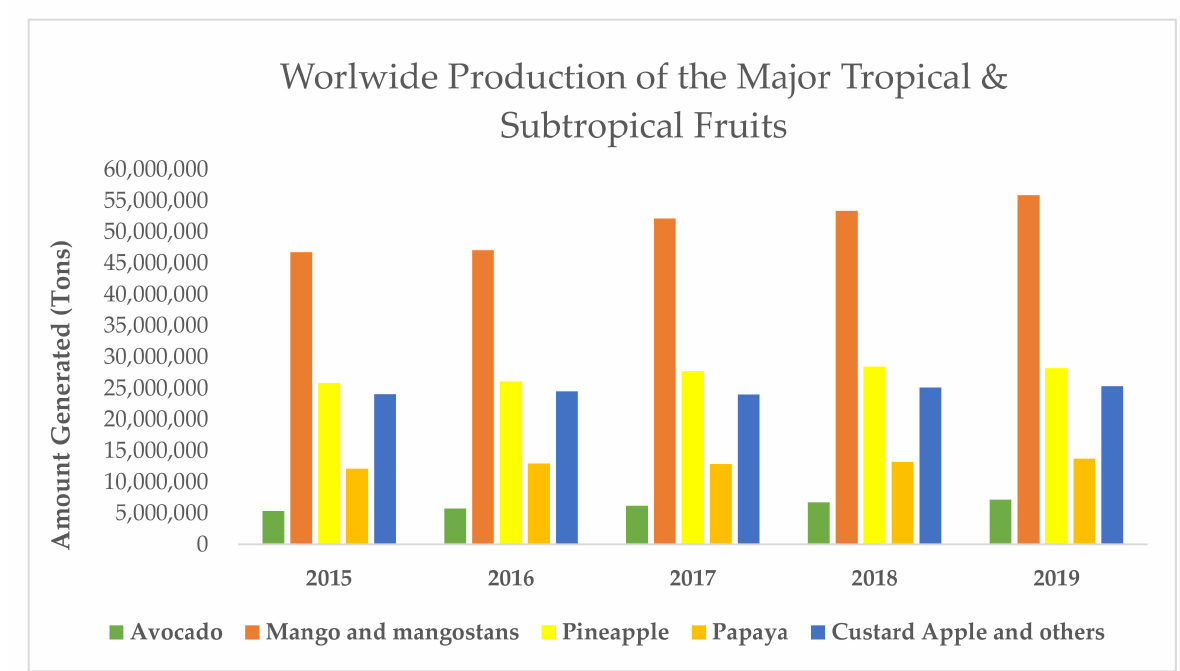
Figure 1. Worldwide production of the major tropical and subtropical